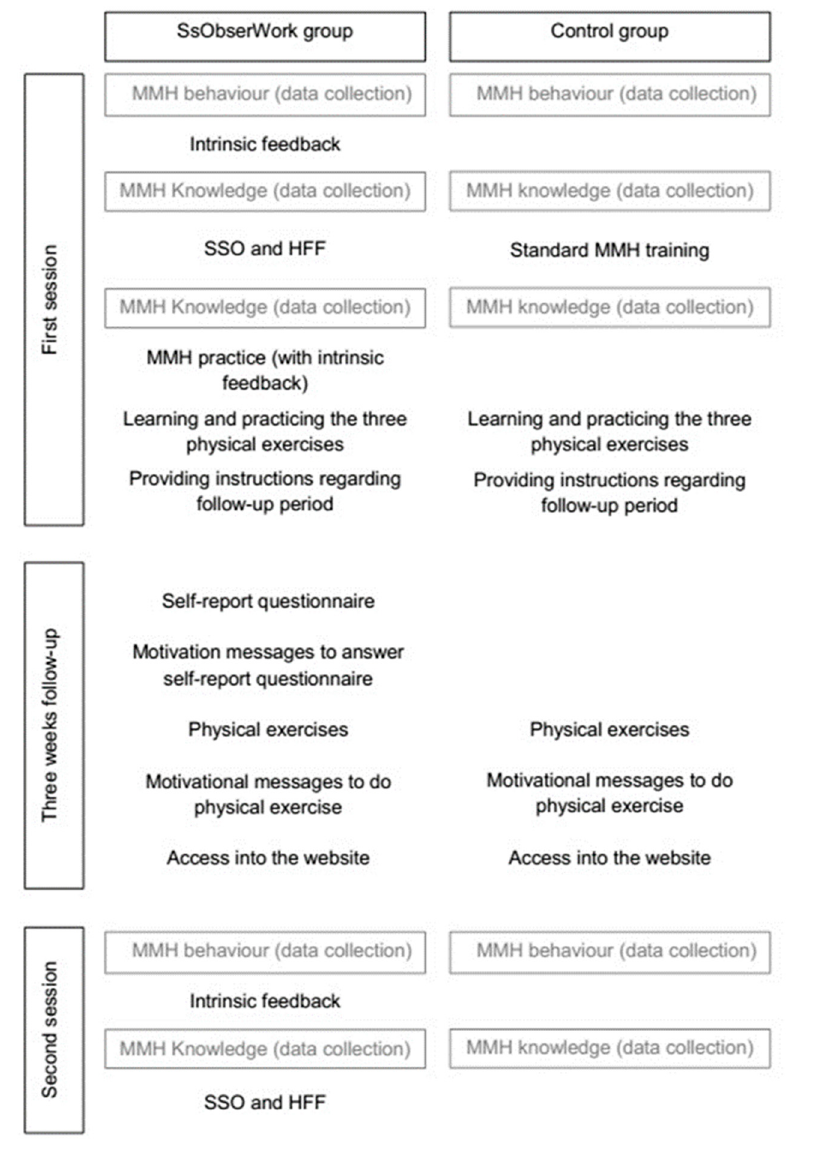
Figure 2. Intervention structure with data collection according to SsObserWork and control groups.